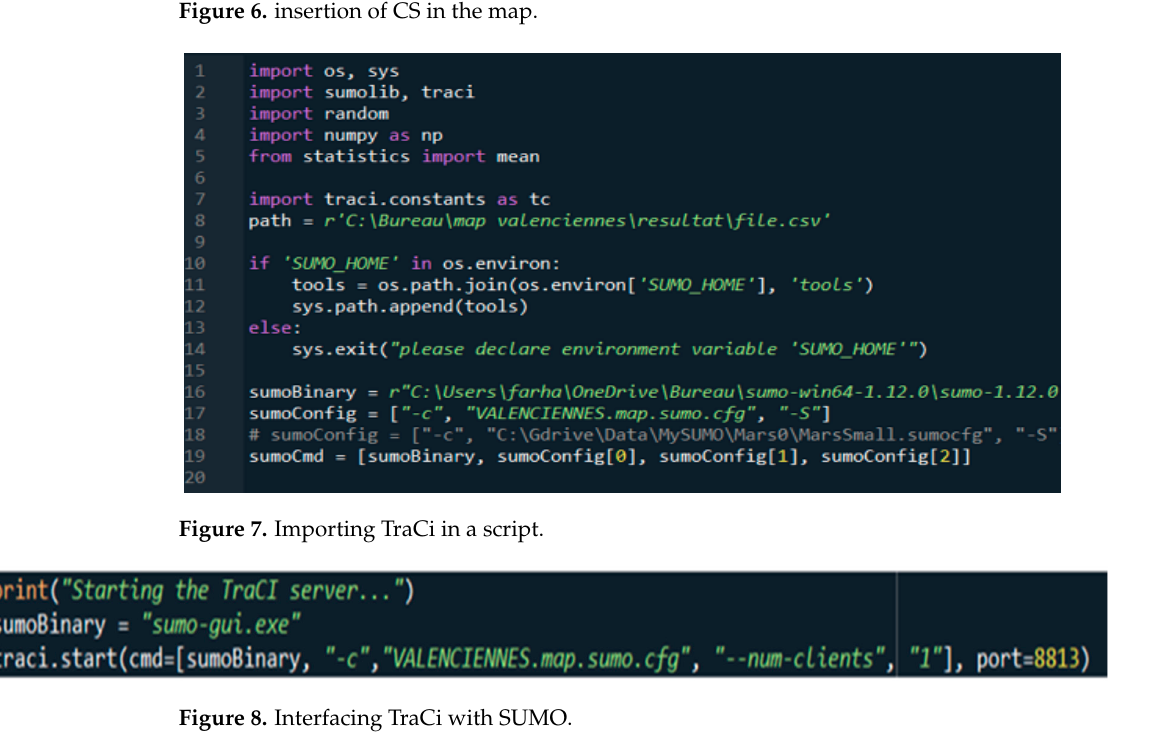
Figure 7. Importing TraCi in a script.